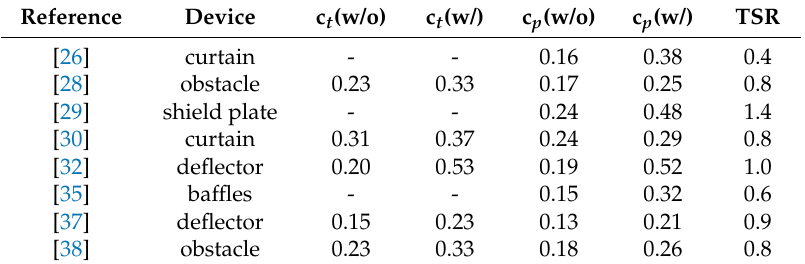
Table 1. Comparison of rotor performance between schemes with and without auxiliary device.